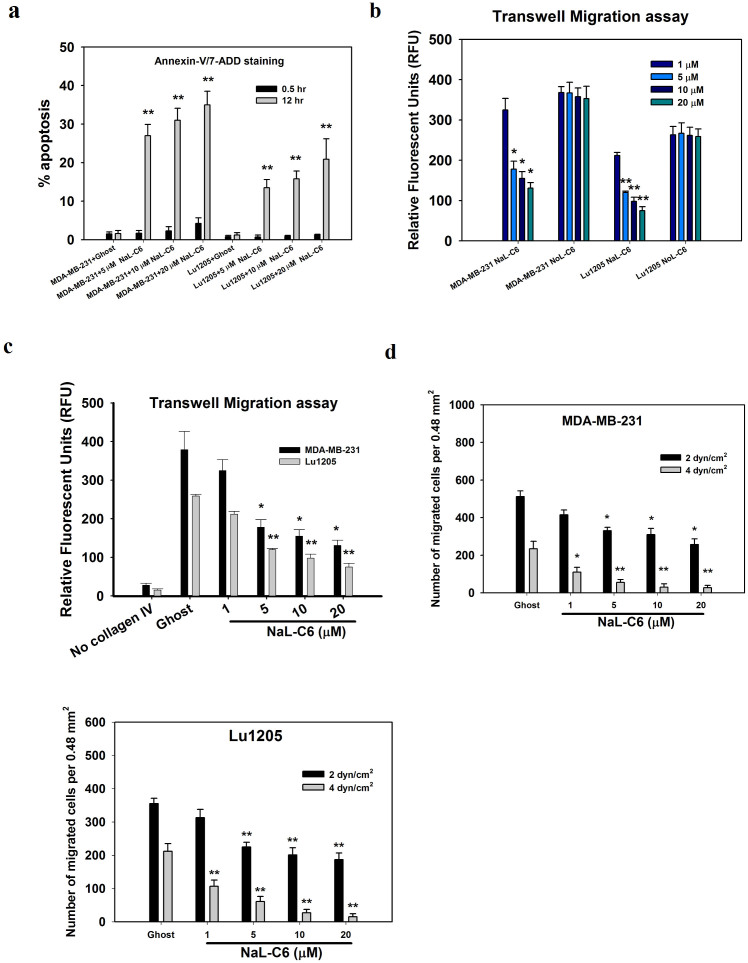
C6-ceramide nanoliposomes suppressed MDA-MB-231 and Lu1205 migration in a dose-dependent manner.(a) MDA-MB-231 or Lu1205 cells did not undergo apoptosis after receiving acute treatment (30 min) of 5 μM, 10 μM or 20 μM ceramide nanoliposome.12-hr treatment with ceramide nanoliposomes induced tumor cell death. % of cells undergoing apoptosis was analyzed with Annexin-v/7-ADD staining and flow cytometry. Values were mean ± SEM. n = three replicates. **p < 0.01 compared with ghost control. (b–c) Liposomal C6 delivery augmented the anti-migration activity of C6-ceramide. MDA-MB-231 or Lu1205 cells received 1 μM, 5 μM, 10 μM or 20 μM liposomal (NaL-C6) or nonliposomal C6-ceramide (NoL-C6) (b) or ghost nanoliposome (c) for 30 min before being used for transwell migration assays. The amounts of migrated cells were determined by calcein AM staining after 4-hr onset of experiment and were expressed as RFU. 100 mg/ml collagen IV was used as chemoattractant in the bottom well. In no collagen IV group, DMEM + 0.1% BSA was added into chemoattractant wells instead. Results were expressed as mean ± SEM. n = three replicates.*p < 0.05, **p < 0.01 compared with control for each cell type.(d) NaL-C6 attenuated MDA-MB-231 or Lu1205 cell transendothelial migration in a dose-dependent manner under flow conditions. Tumor cells were incubated with 1 μM, 5 μM, 10 μM or 20 μM NaL-C6 or ghost nanoliposome for 30 min before being introduced into flow migration chamber together with 1.5 mg/ml fibrinogen. The flow migration assay was carried out for 4 hr at shear stress of 2 or 4 dyn/cm2. The migrated cancer cells were stained and counted at the bottom of filter. Results were expressed as mean ± SEM. n = three replicates.*p < 0.05, **p < 0.01compared with ghost at the same shear stress.